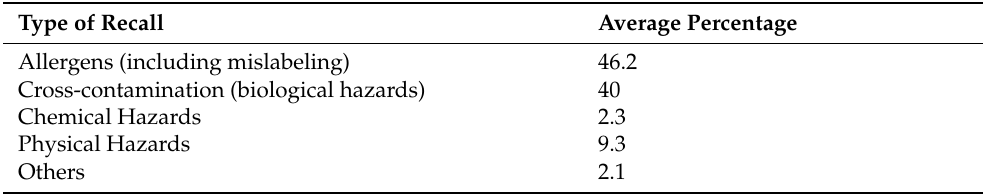
Table 1. Global food Safety incidents and/or recalls according to hazards from 2008–2018 [1,25]. Type of